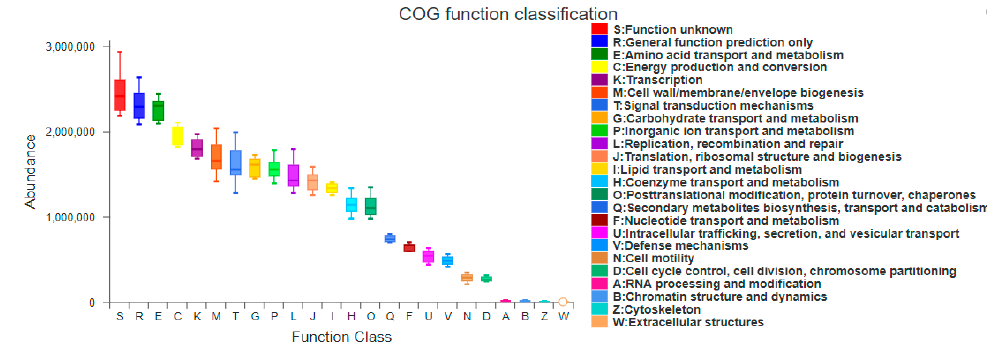
Figure 9. PICRUSt function abundance spectrum in the COG database. The X-axis represents the secondary function number of COG, and Y-axis represents the functional abundance.